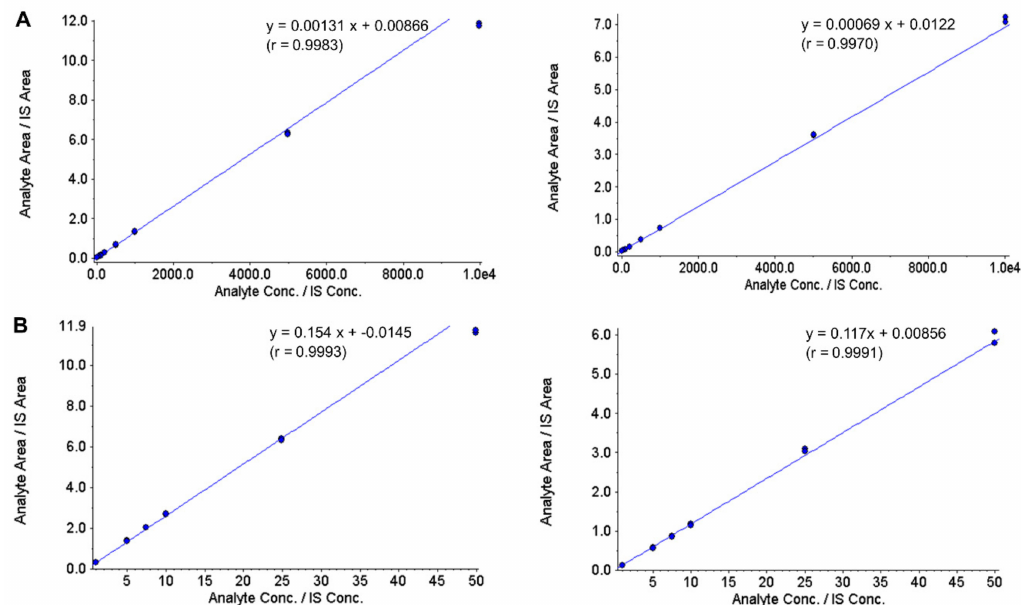
Figure 1. Representative calibration curves of thymidine (left panel) and 2’-deoxyuridine (right panel) in plasma ( A ) and urine ( B ) quantified by LC-MS / MS. Calibration standards ranged between 10 and 10,000 ng / mL in plasma and 1 and 50 µ g / mL in